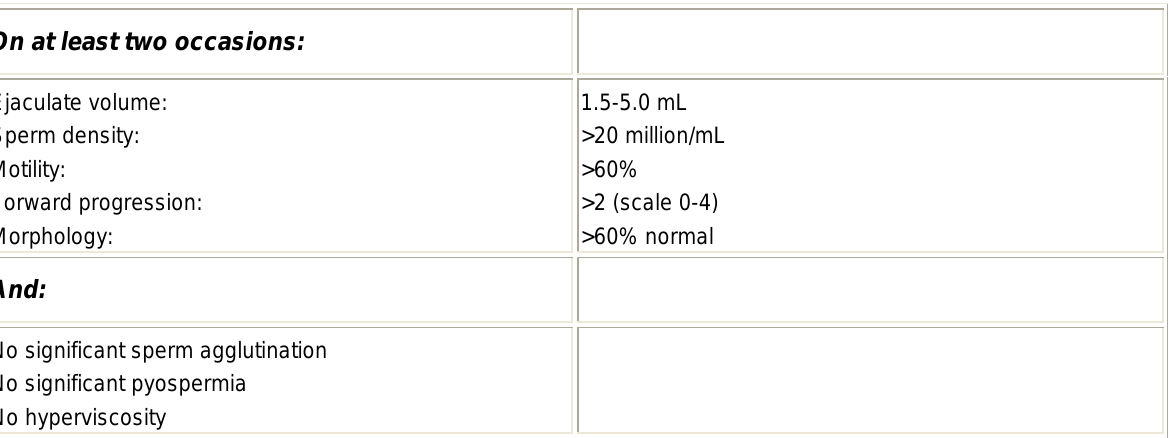
Semen Analysis: Minimal Standards of